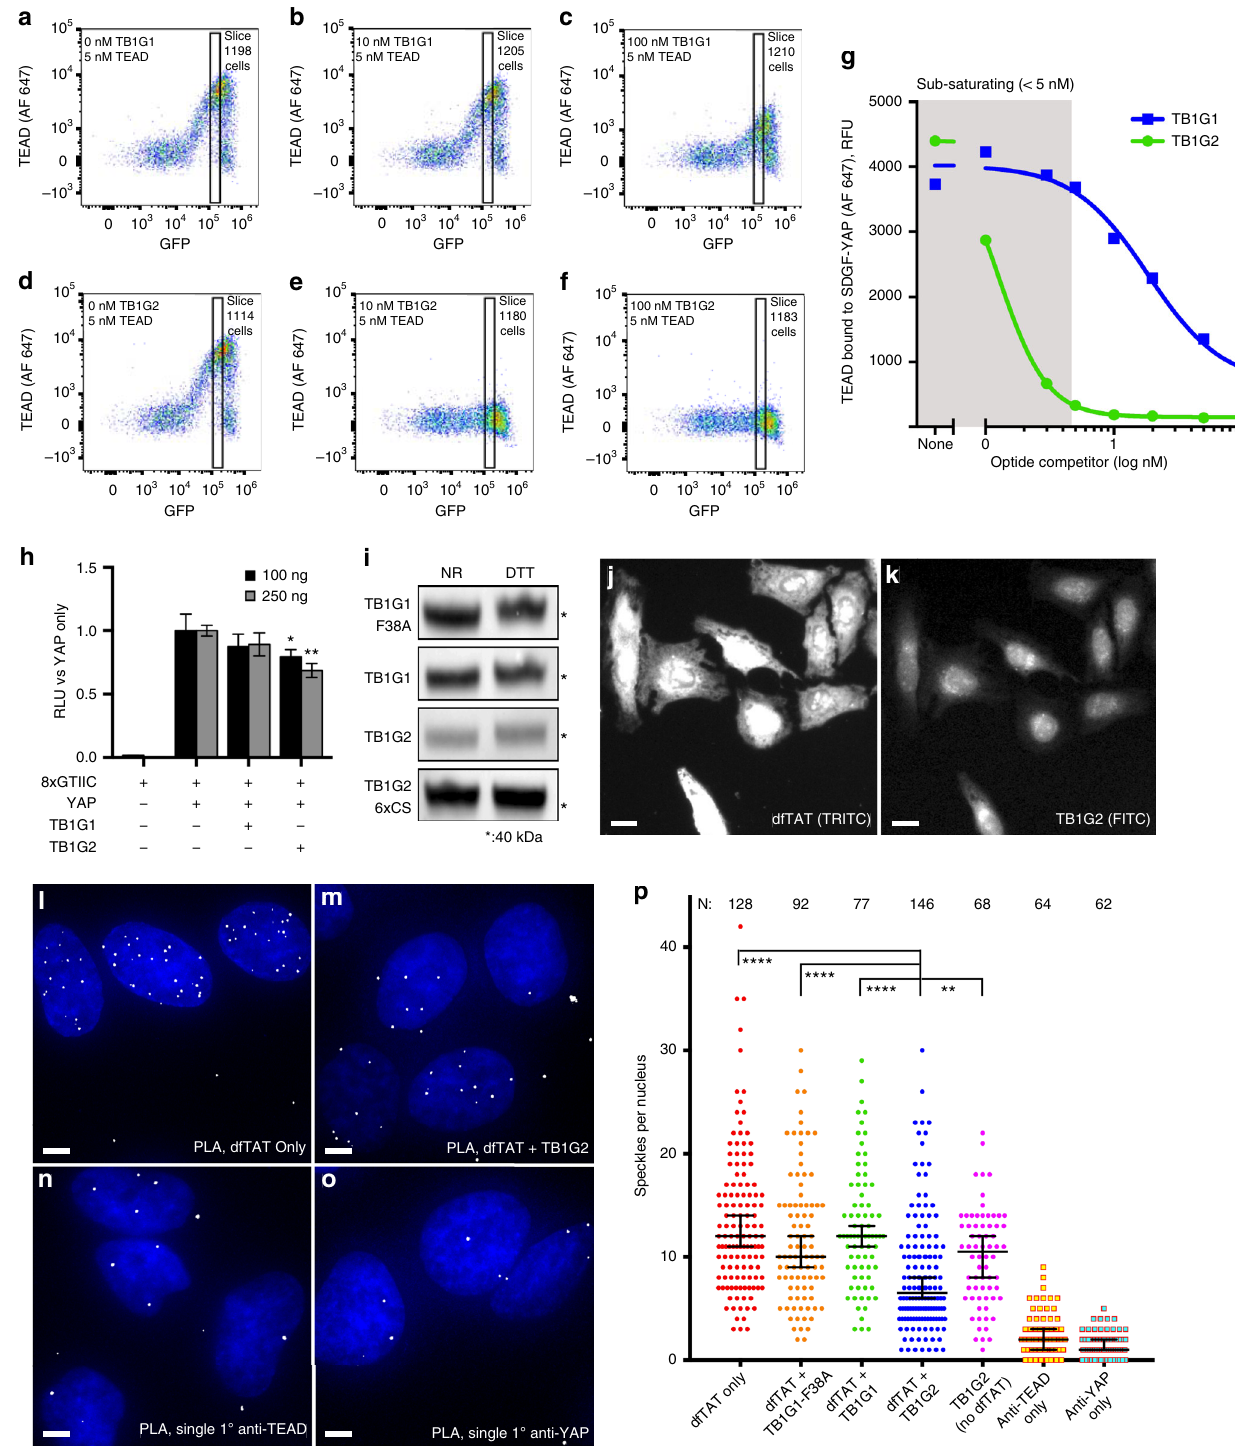
NATURE COMMUNICATIONS | 8:2244 | DOI: 10.1038/s41467-017-02098-8 |